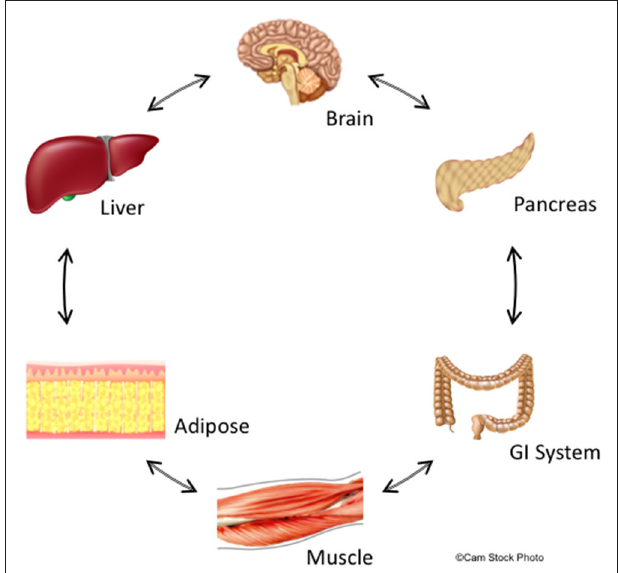
FIGURE 1 | Summary of central and peripheral mechanisms contributing to deleterious effects of schizophrenia and APDs on glucose and lipid metabolism. The central nervous system,including metabolically-relevant areas in the brain such as hypothalamus, receive feedback from peripheral organs that regulate metabolism and appetite. Likewise, metabolic centers in the brain regulate metabolism throughout the body via actions on peripheral organs including GI tract, liver, pancreas, adipose tissue, and skeletal muscle. This feedback is bidirectional though non-sequential, and creates a delicate metabolic balance that is disturbed by biological changes intrinsic to schizophrenia and is further perturbed by APDs. We hypothesize that these central and peripheral target organs are linked through common molecular signaling networks involving dopaminergic, serotoninergic, histaminergic, and adipokine signaling. Since APDs act at receptors for these signaling systems, these drugs may have synergistic properties that significantly increase the risk of developing metabolic disturbances including insulin resistance and